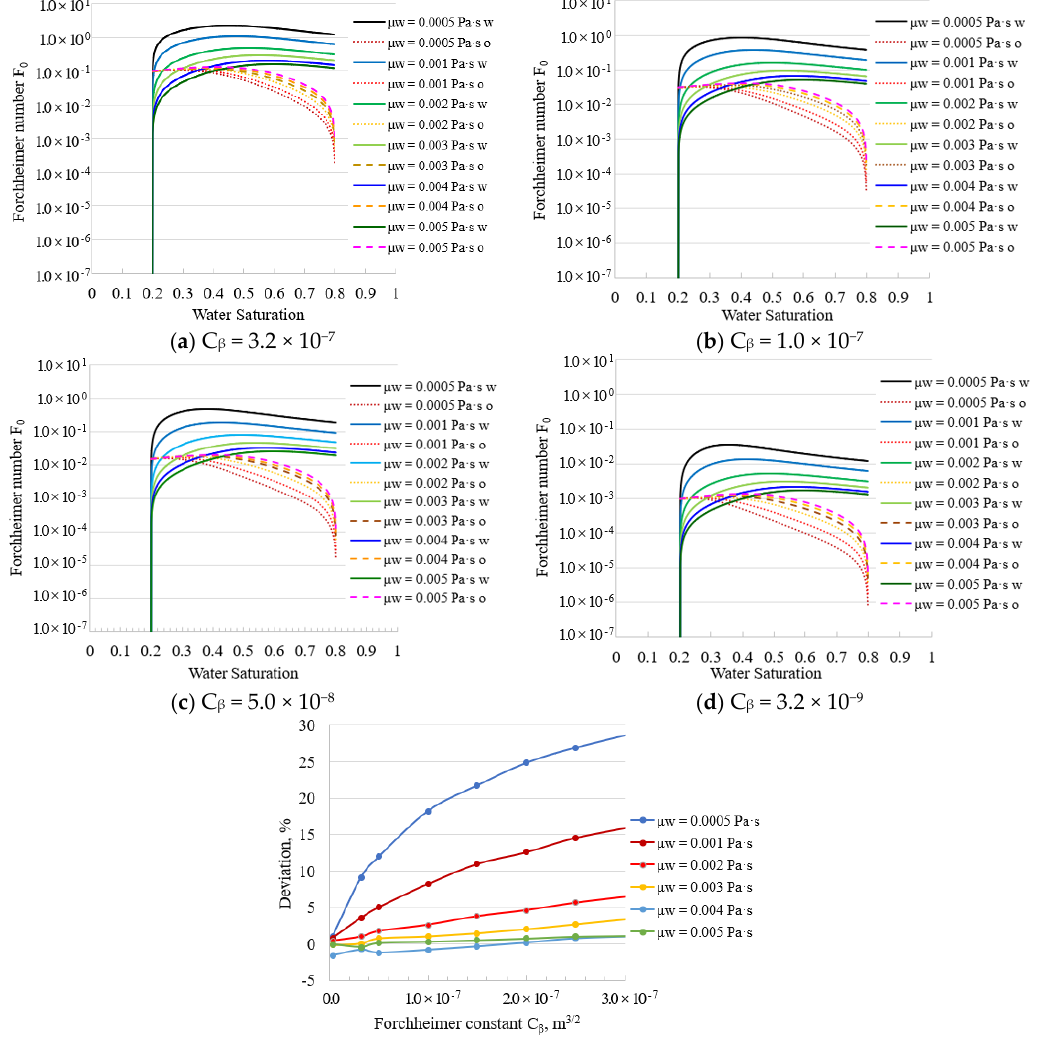
Figure 7. Forchheimer number F 0 of Forchheimer flow with different fluid viscosities.